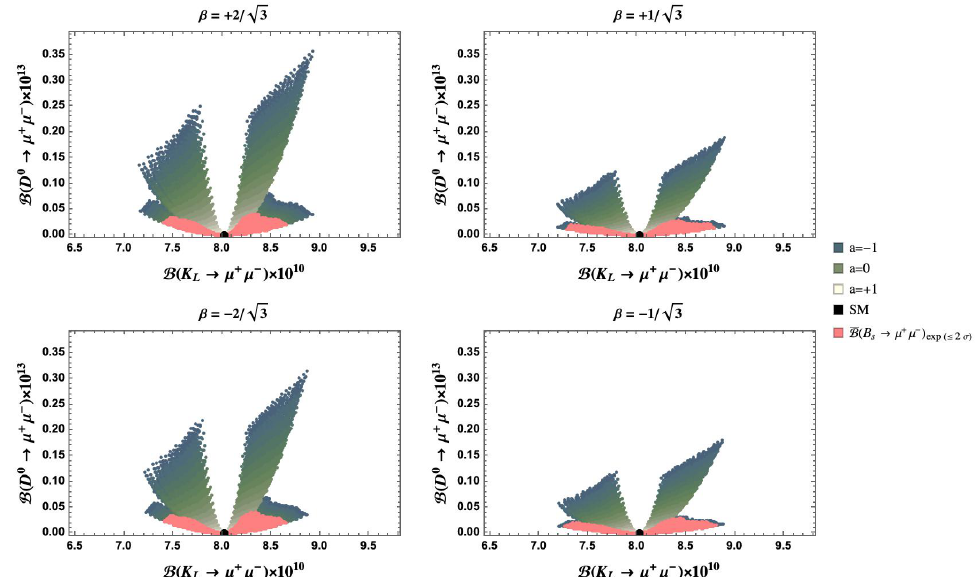
Figure 12 . Correlation between B ( D 0 → µ + µ − ) and B ( K L → µ + µ − ) in 331 models with parame- ters as in figure 8. The black dot represents the SM result. The pink points are obtained requiring B ( B s → µ + µ − ) in the experimental range within 2 σ